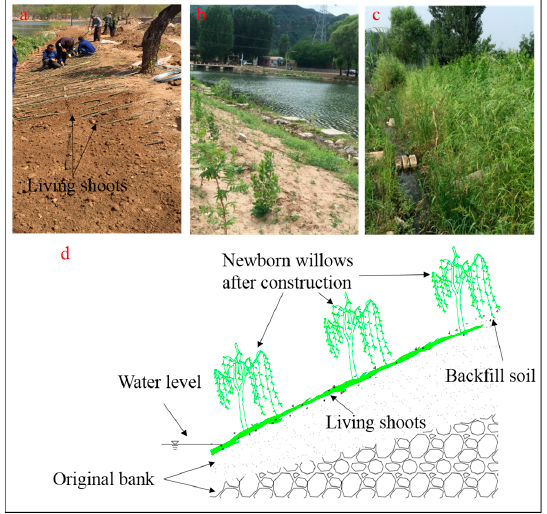
Figure 2. Construction effect diagram of a living brush mattress. ( a ) Under construction; ( b ) one month